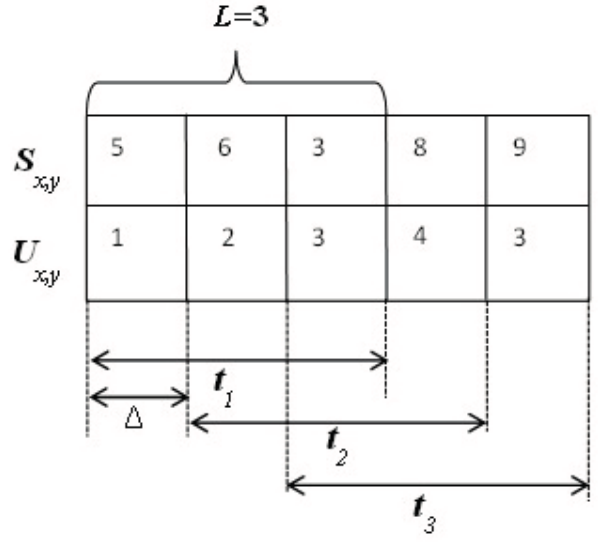
Figure 1. Example of the time-window